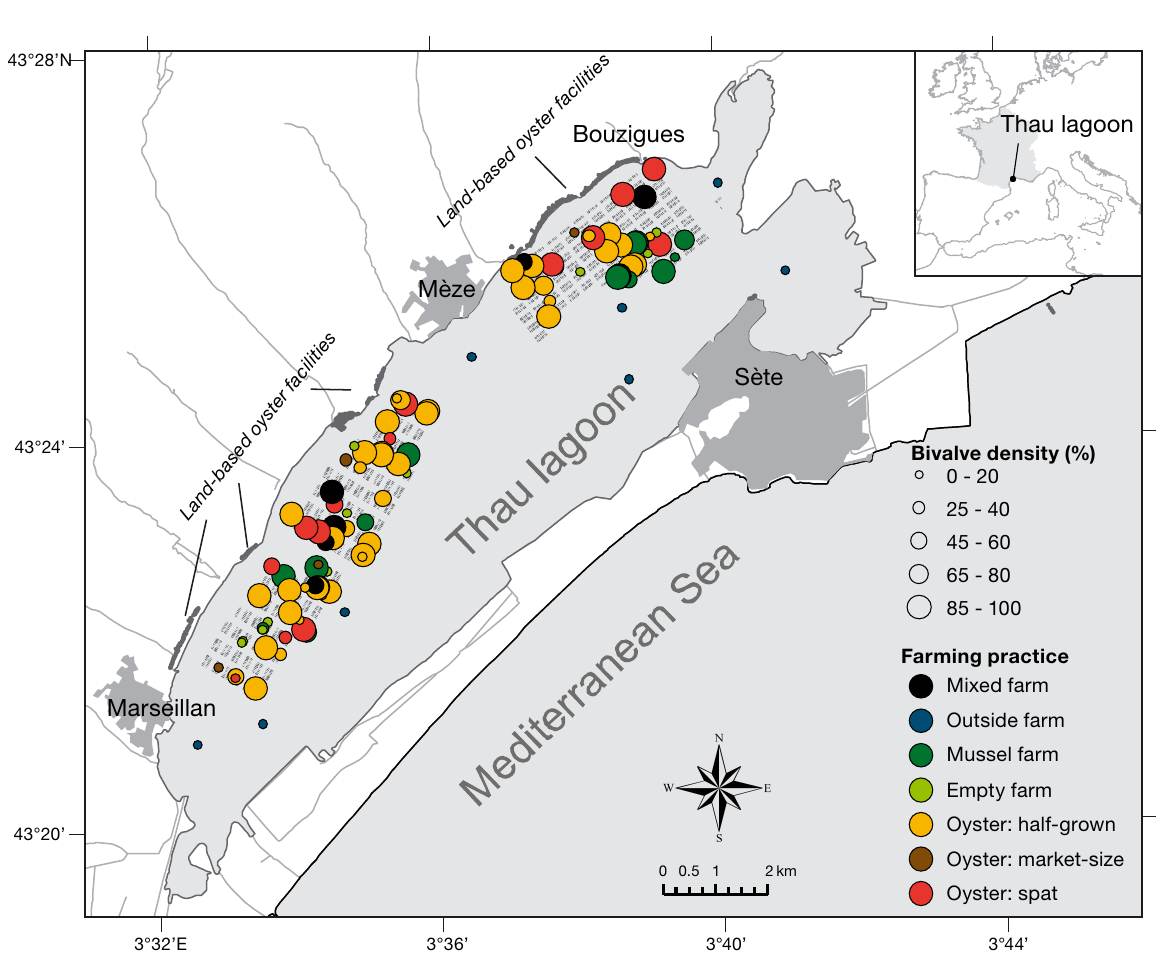
Fig. 1. Farming practices at sampling sites in the Thau lagoon, France. Areas with small grey boxes represent bivalve farms. Oyster: Crassostrea gigas ; mussel: Mytilus